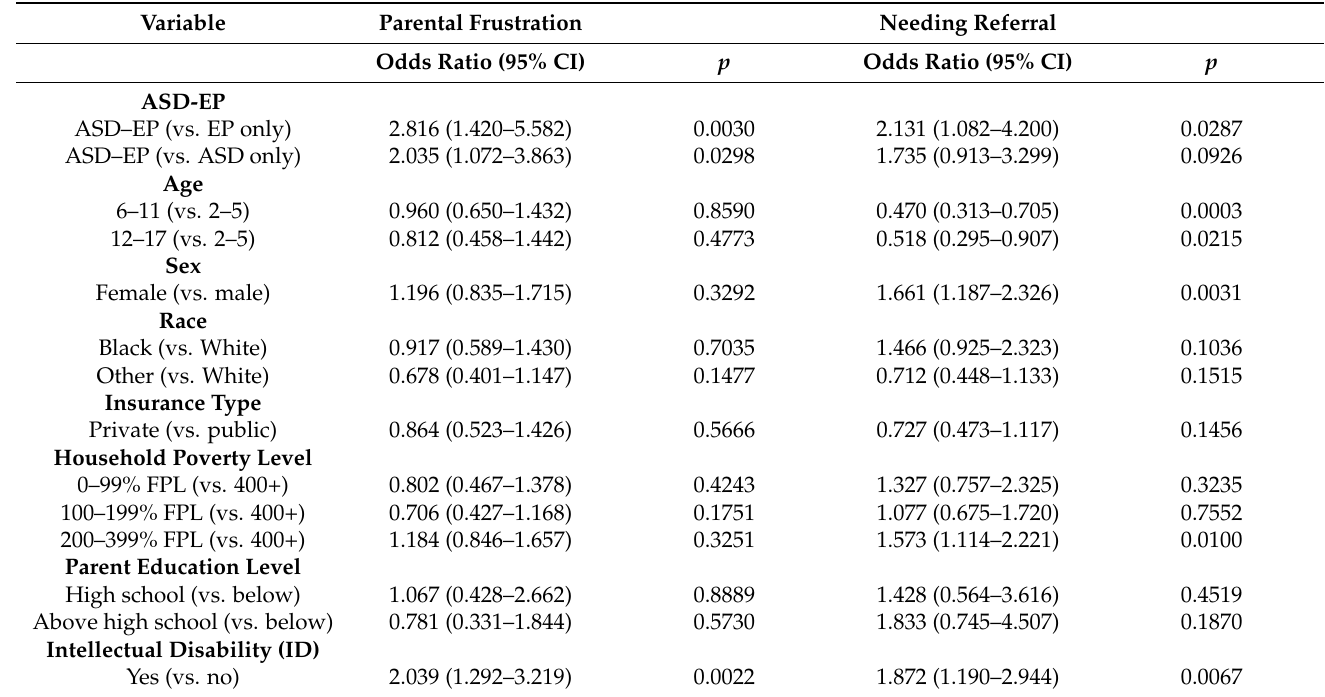
Table 3. Adjusted odds ratios for parental frustration and needing